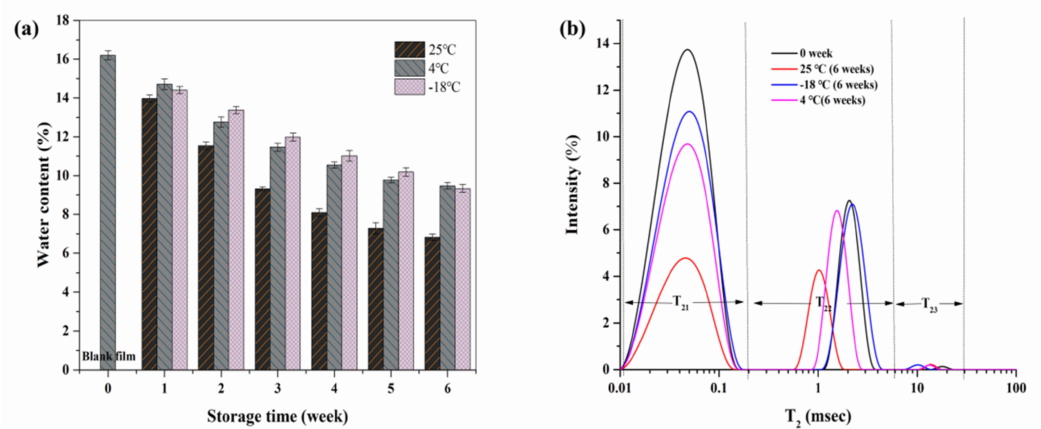
Figure 2. The water content ( a ) and LF-NMR ( b ) of SPI edible films stored at different temperatures (25 ◦ C, 4 ◦ C, and − 18 ◦